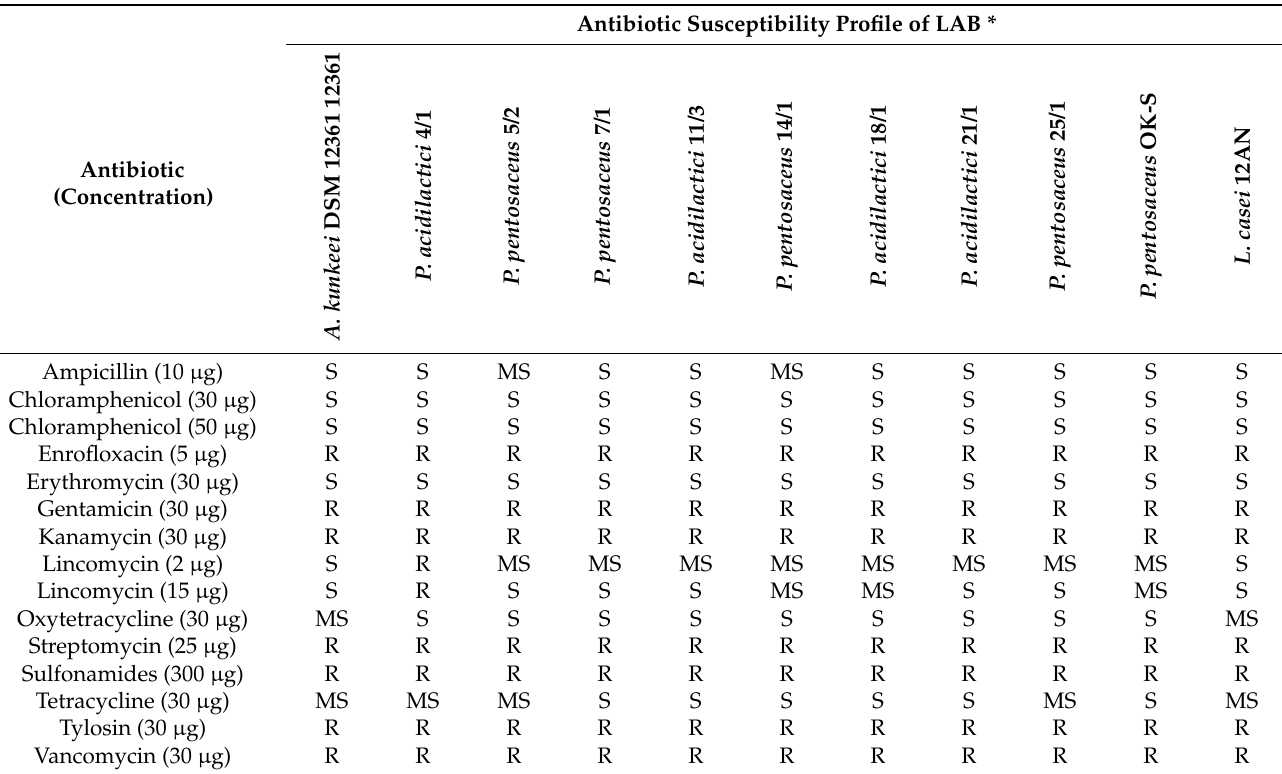
Table 1. Antibiotic susceptibility profile of lactic acid bacteria (LAB) isolates. Antibiotic Susceptibility Profile of LAB *